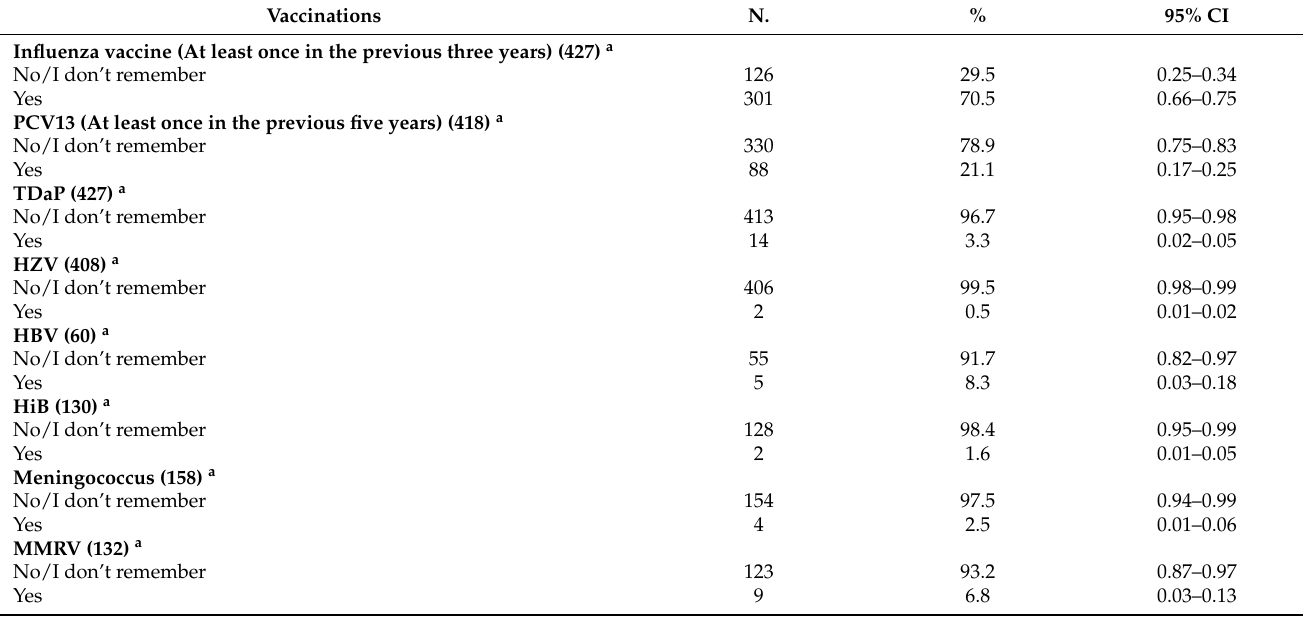
Table 2. Self-reported vaccination coverage prevalence of the study population.